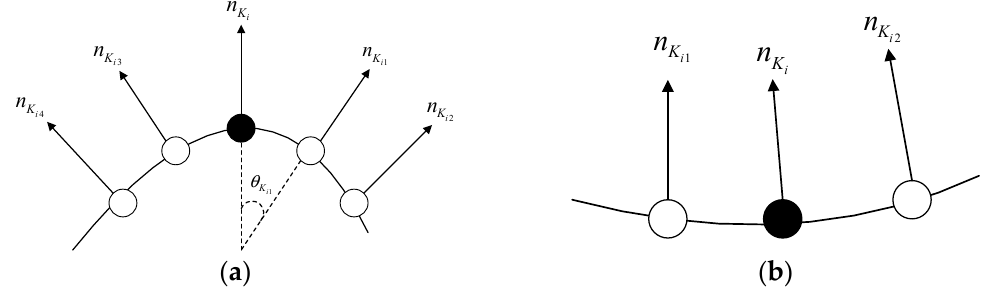
Figure 2. Angle between the normal vector of the feature and non-feature areas. ( a ) the normal vector of the feature area; ( b ) the normal vector of the non-feature area.